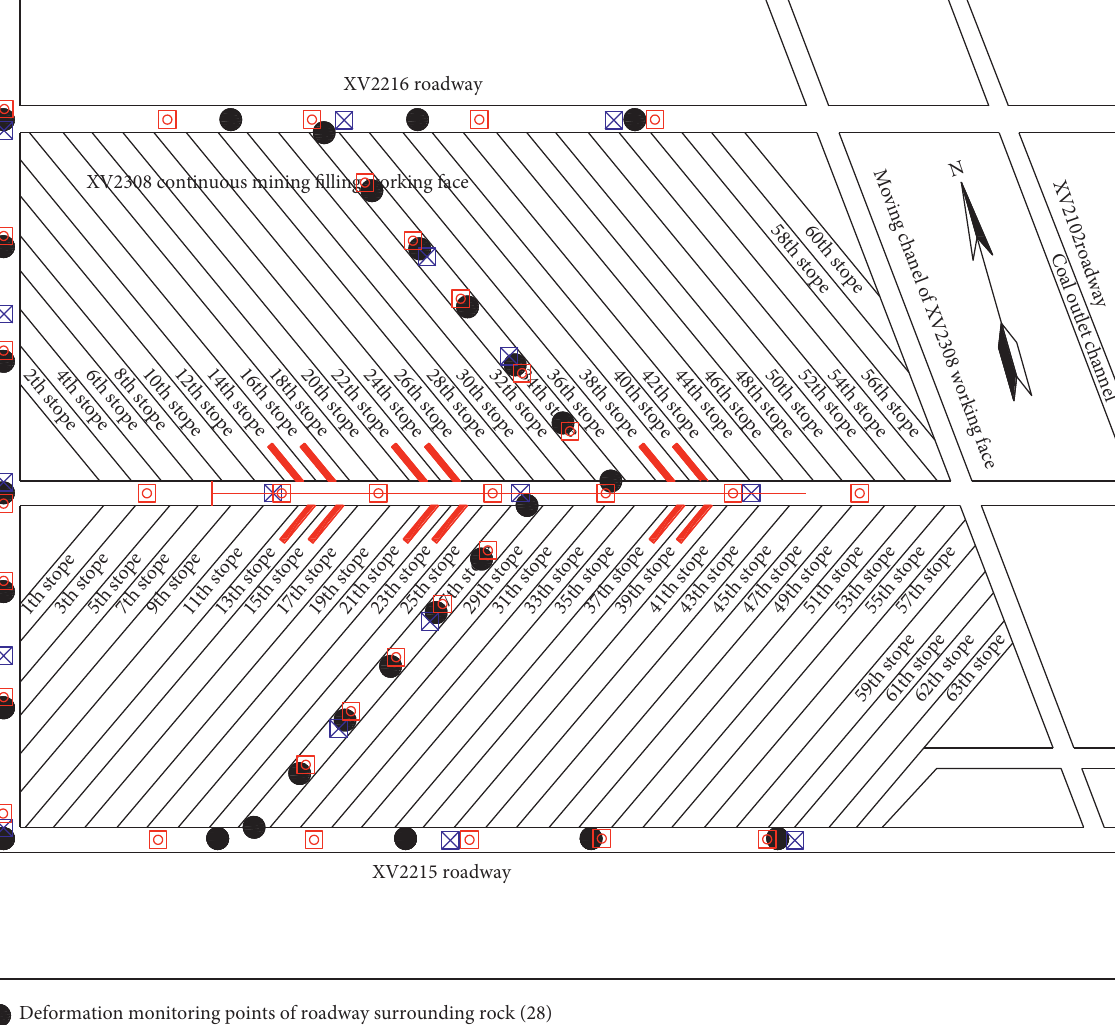
Figure 11: The layout of the monitoring stations.